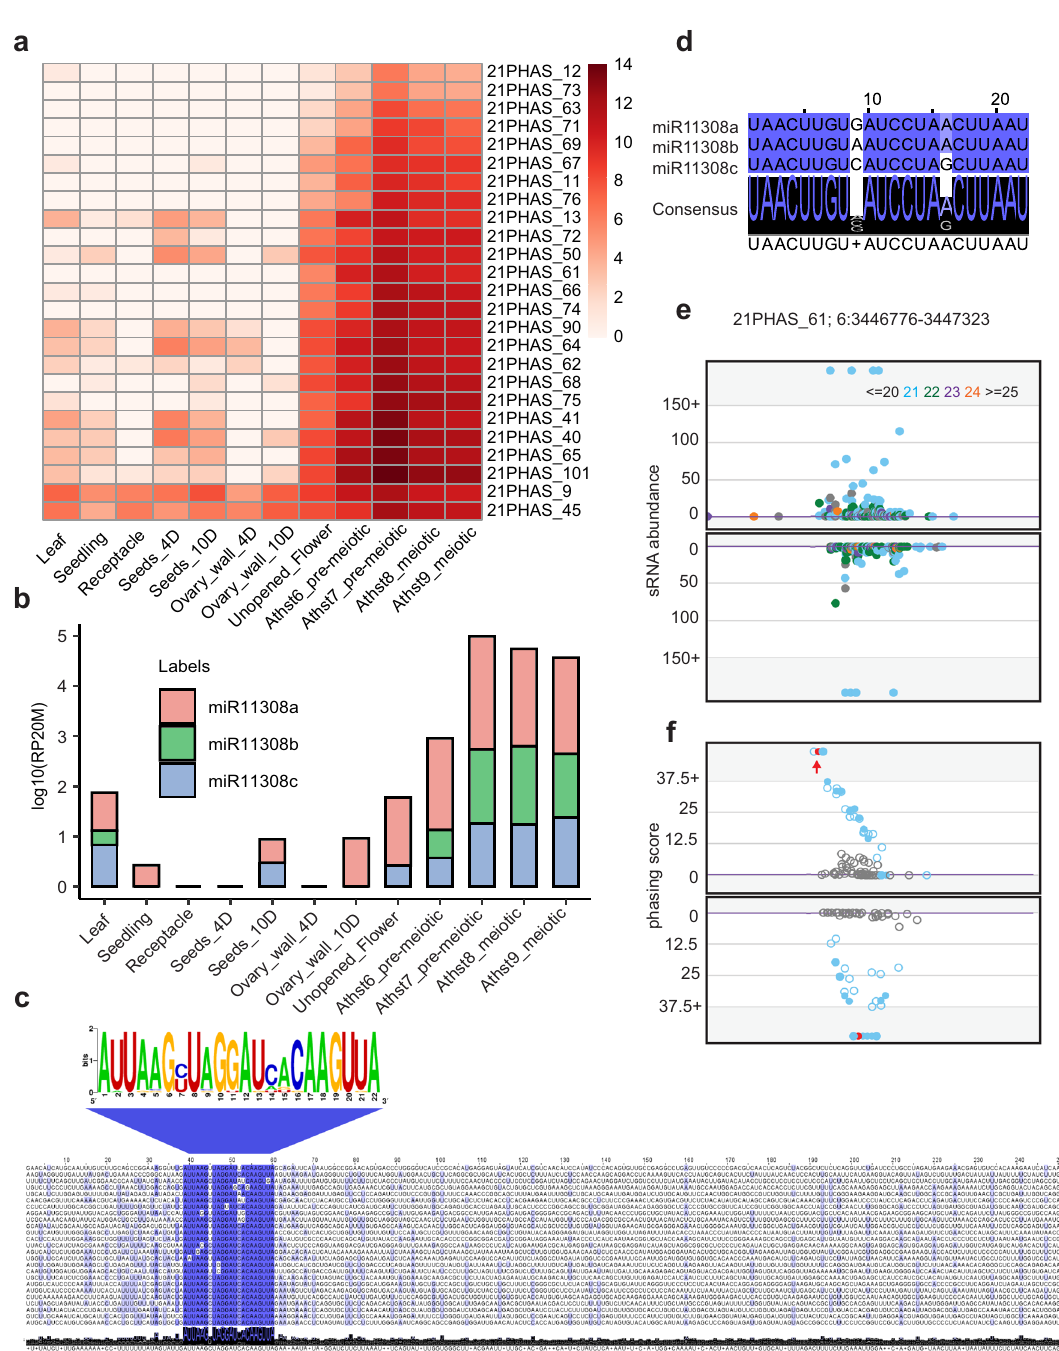
Fig. 1 Reproductive 21 nt phasiRNAs triggered by miRNA miR11308 are abundant in wild strawberry. a Expression of 21 nt reproductive phasiRNAs in different tissues and anther development stages. The key at the right indicates the abundance in units of log2(RP20M). RP20M: reads per 20 million mapped reads. Athst: anther stage. b Abundance of miR11308 members in log10(RP20M) in different tissues of wild strawberry. c Above: sequence logo denoting conservation of target site of miR11308 for 25 21- PHAS loci. Below: nucleotide sequence alignment of 21- PHAS loci with sequence similarity denoted by the intensity of the blue color showing that the miR11308 target site is the only conserved region for all the precursors. d Alignment of members of the miR11308 family in wild strawberry. The degree of conservation is denoted by intensity of the blue color; the consensus sequence of the alignment is shown with a sequence logo. e Abundance (RP15M) of small RNAs in both strands of an example locus padded with 500 base pairs, each side. sRNA sizes are denoted by colors, as indicated at the top. f Phasing score of same locus as e ; the red dot indicates the highest phased sRNA position. The red dot also represents the coordinate (3,446,776), which exactly coincides with the predicted cleavage site of miR11308, denoted by the red arrow. Source data underlying Fig. 1a, b are provided as a Source Data fi